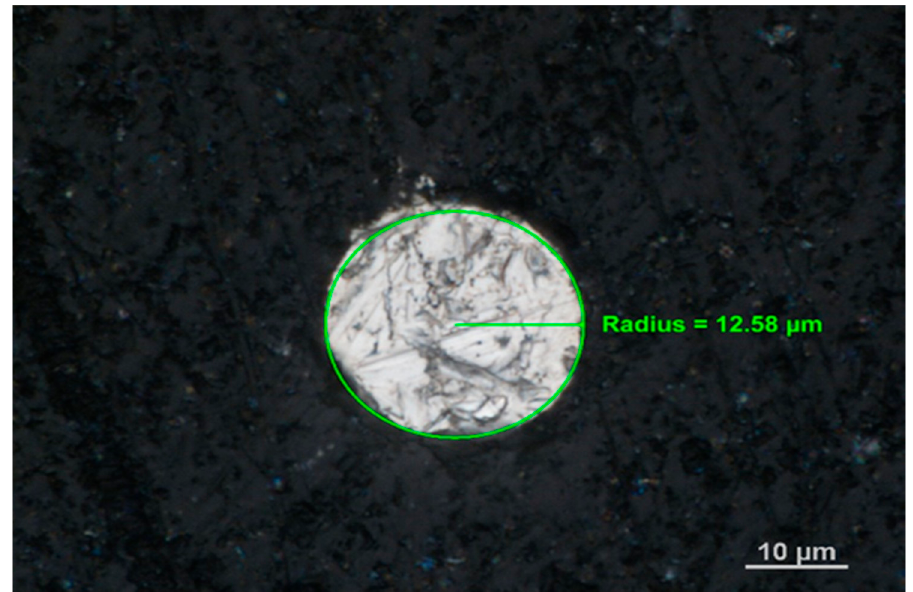
Figure 1. A microscopic image of the solid bismuth microelectrode with the marked radius.